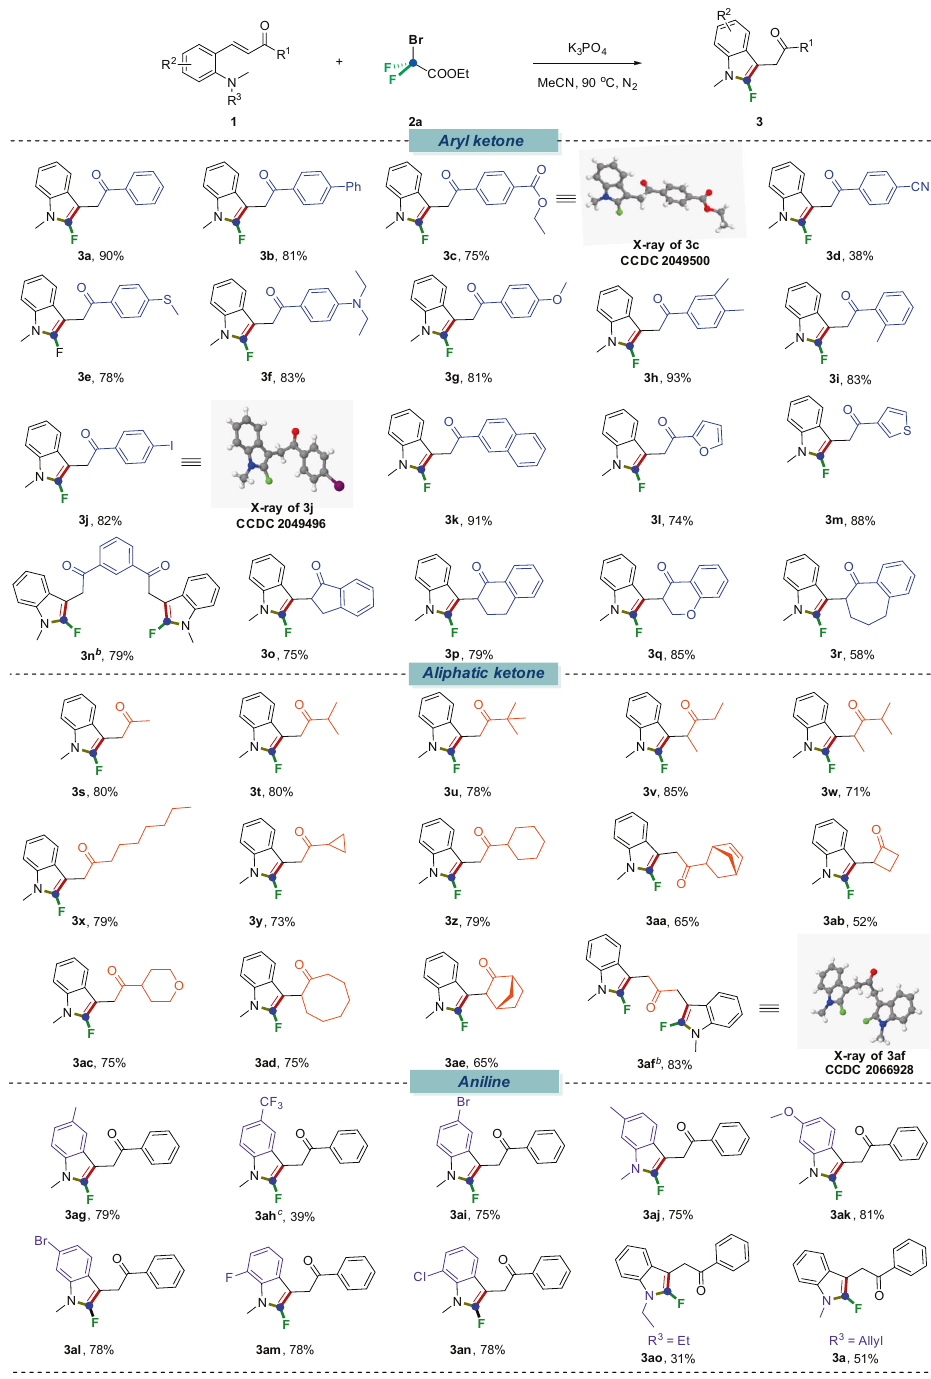
Fig. 2 Scope of the α , β -unsaturated ketone-containing anilines a . Reaction conditions: a 1 (0.2 mmol), 2a (3 equiv., 0.6 mmol), K 3 PO 4 (3 equiv.), H 2 O (0.1 mL), CH 3 CN (2 mL) under 90 °C for 12 h, N 2 . b 1 (0.2 mmol), 2a (6 equiv., 1.2 mmol), K 3 PO 4 (6 equiv.), H 2 O (0.15 mL), CH 3 CN (3 mL) under 90 °C for 12 h, N 2 . c 24